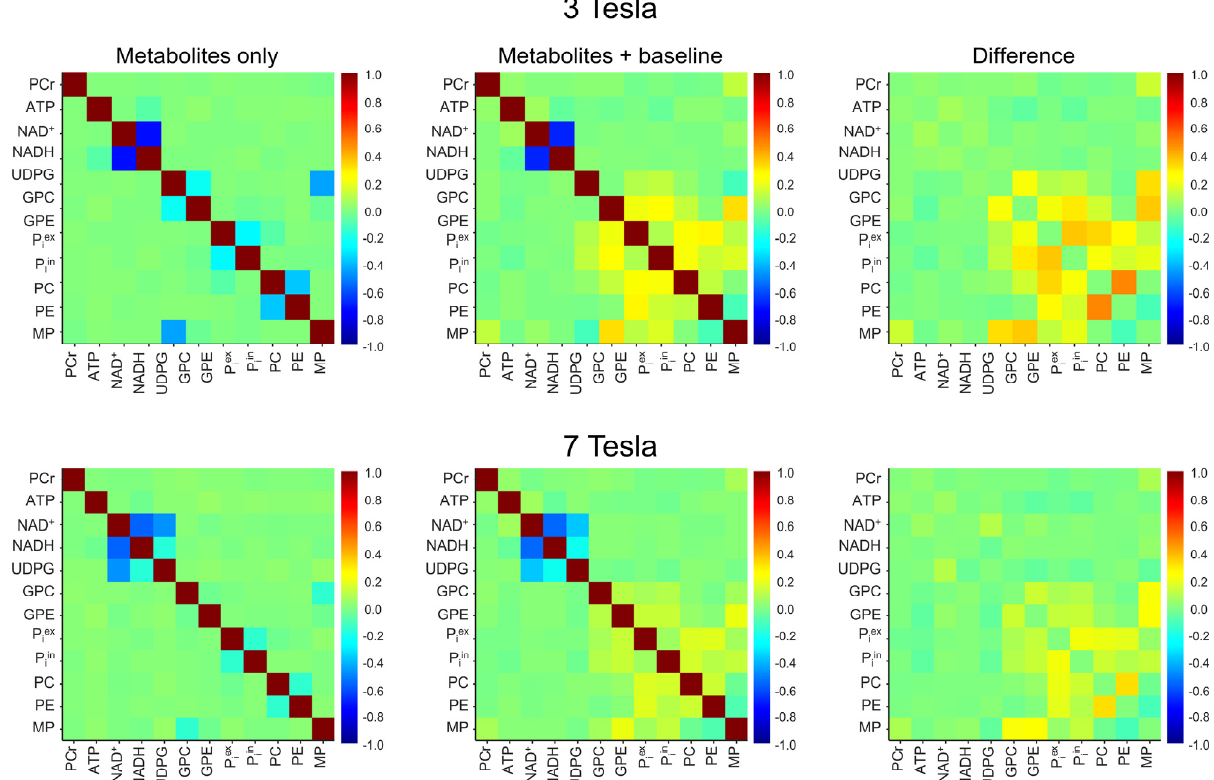
Figure 3. Mean cross-correlation coefficient matrices derived from Monte Carlo analysis of the in vivo 3 Tesla (n = 5; top row) and 7 Tesla (n = 5; bottom row) 31 P MRS spectra. The Monte Carlo analysis was performed for two different scenarios: metabolites only (first column) and metabolites + baseline (second column). The matrices in the third column represent the differences obtained by subtracting the matrices in the first column from those in the second column.